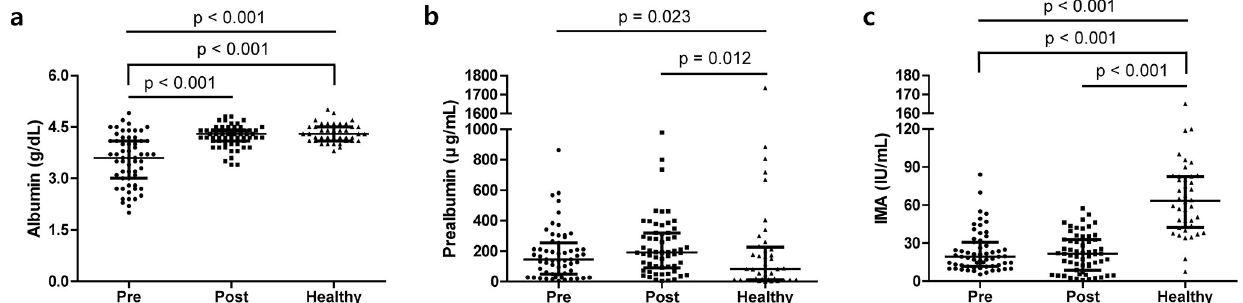
Fig 1. Albumin, prealbumin, and ischemia-modified albumin levels upon serial testing and comparison with healthy controls. (a) Albumin levels were significantly lower at baseline compared with levels at follow-up and in healthy controls. (b) Prealbumin was found to be significantly higher at follow-up than in healthy controls. (c) Ischemia-modified albumin levels were significantly higher in healthy controls than the levels at baseline and at follow-up. The error bars present median and interquartile range. IMA: ischemia-modified albumin.